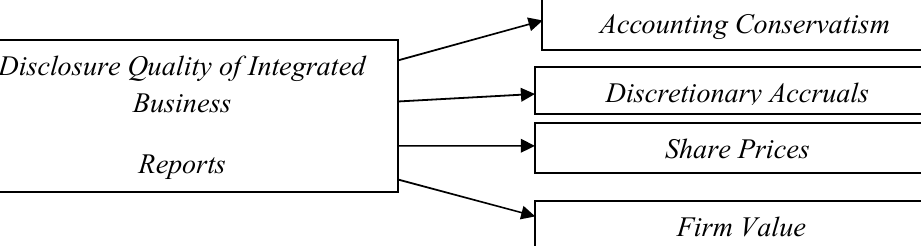
Fig. 1. Conceptual model of hypothesized